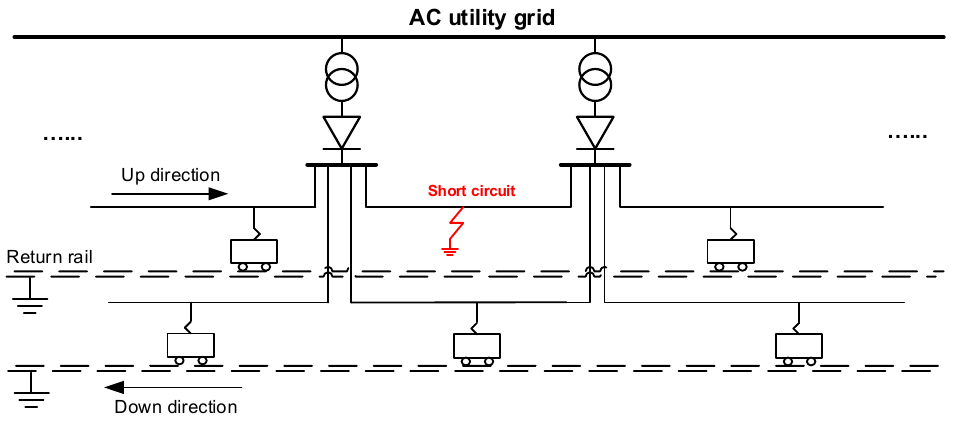
Figure 8. Topology of a short-circuit fault.